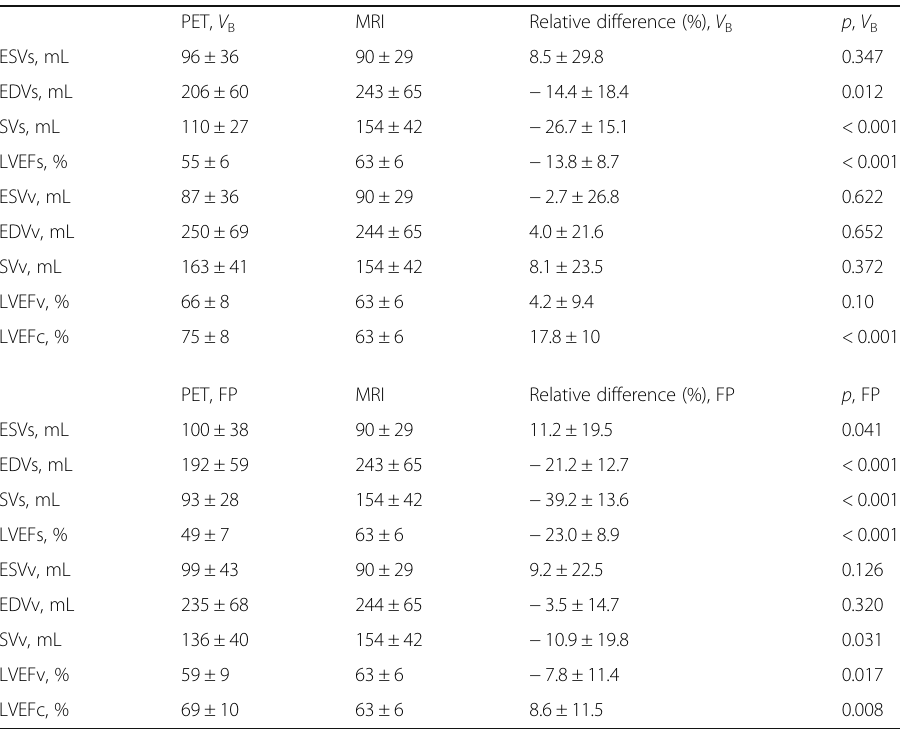
Table 4 Including outliers, average LV volumes and LVEF calculated from PET using surface- (s), count- (c), and volume-based (v) methods compared with average values from MRI